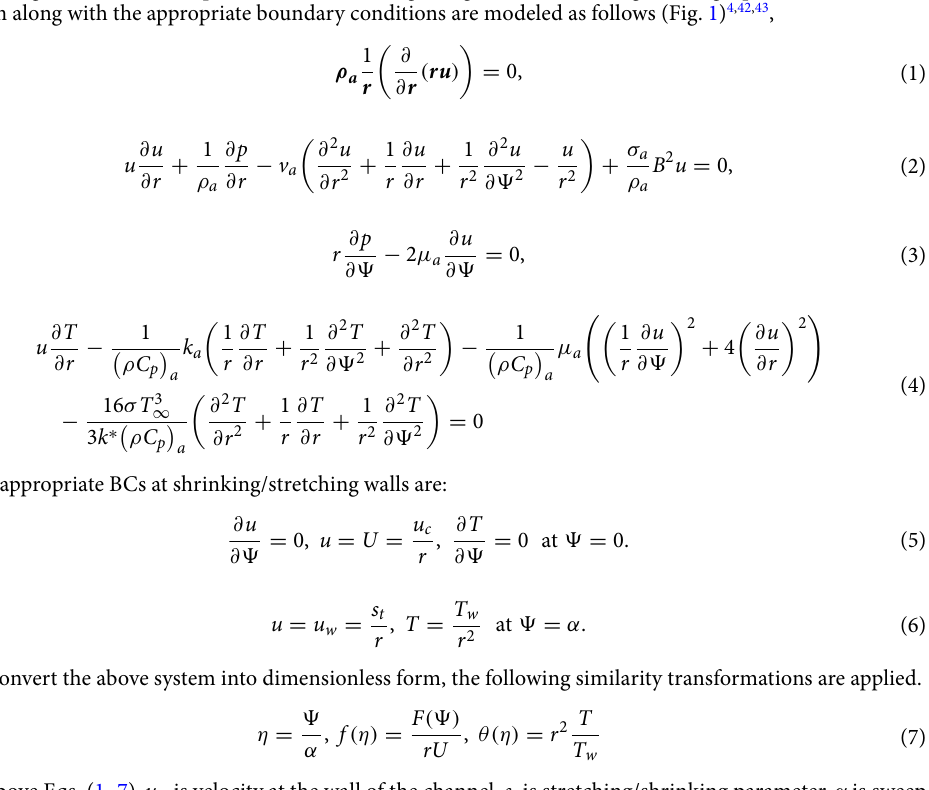
nonlinear ODEs. The Bruggeman model is used to obtain the thermal conductivity of aggregation. The effects of different parameters like radiation, volume fraction by nanoparticles, Reynolds number, sweep angle, stretching/ shrinking parameter, Eckert number on velocity field, temperature field and entropy generation are discussed graphically.